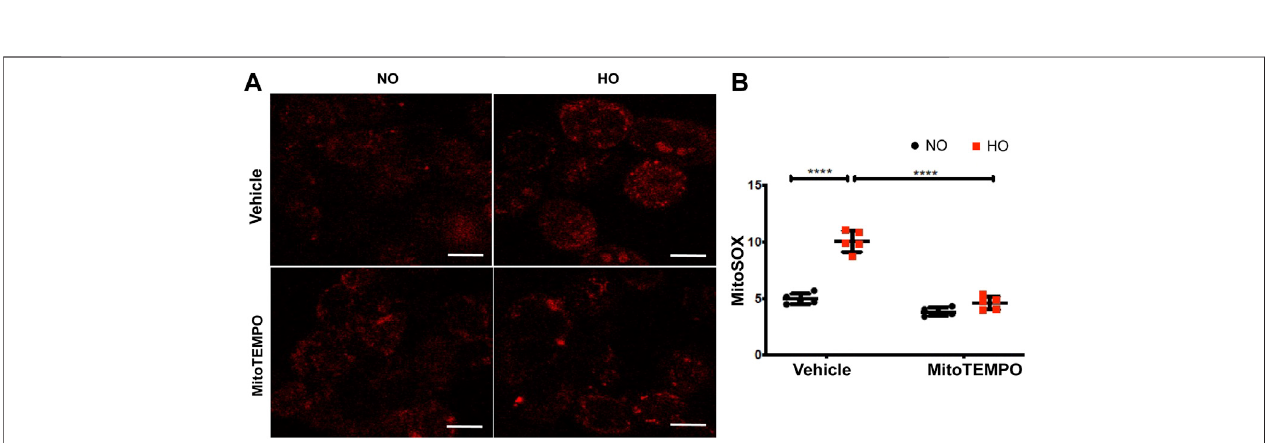
FIGURE 9 | NOX4 expression regulates HO-induced apoptosis in lung epithelial cells. MLE-12 cells were transfected with NOX4 siRNA or control scrambled RNA for 24 h before HO exposure and apoptosis was assessed by fl ow cytometry. (A) Representative dot plots of cells stained with Annexin and 7-AAD (B) Graphs representing the percent fold-change of Annexin V- positive cells showing an increase in percentage fold change of apoptosis in HO group which was reduced in the siRNA treated cells. n = 3. *** p < 0.001, * p < 0.05.